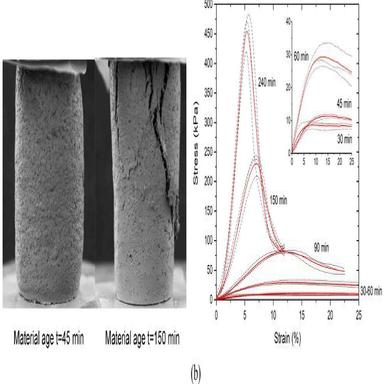
(a) Typical failures observed in green strength tests at different material ages; (b) Typical stress-strain relations in green strength tests. Modified from Ref.. (For interpretation of the references to colour in this figure legend, the reader is referred to the Web version of this article.)